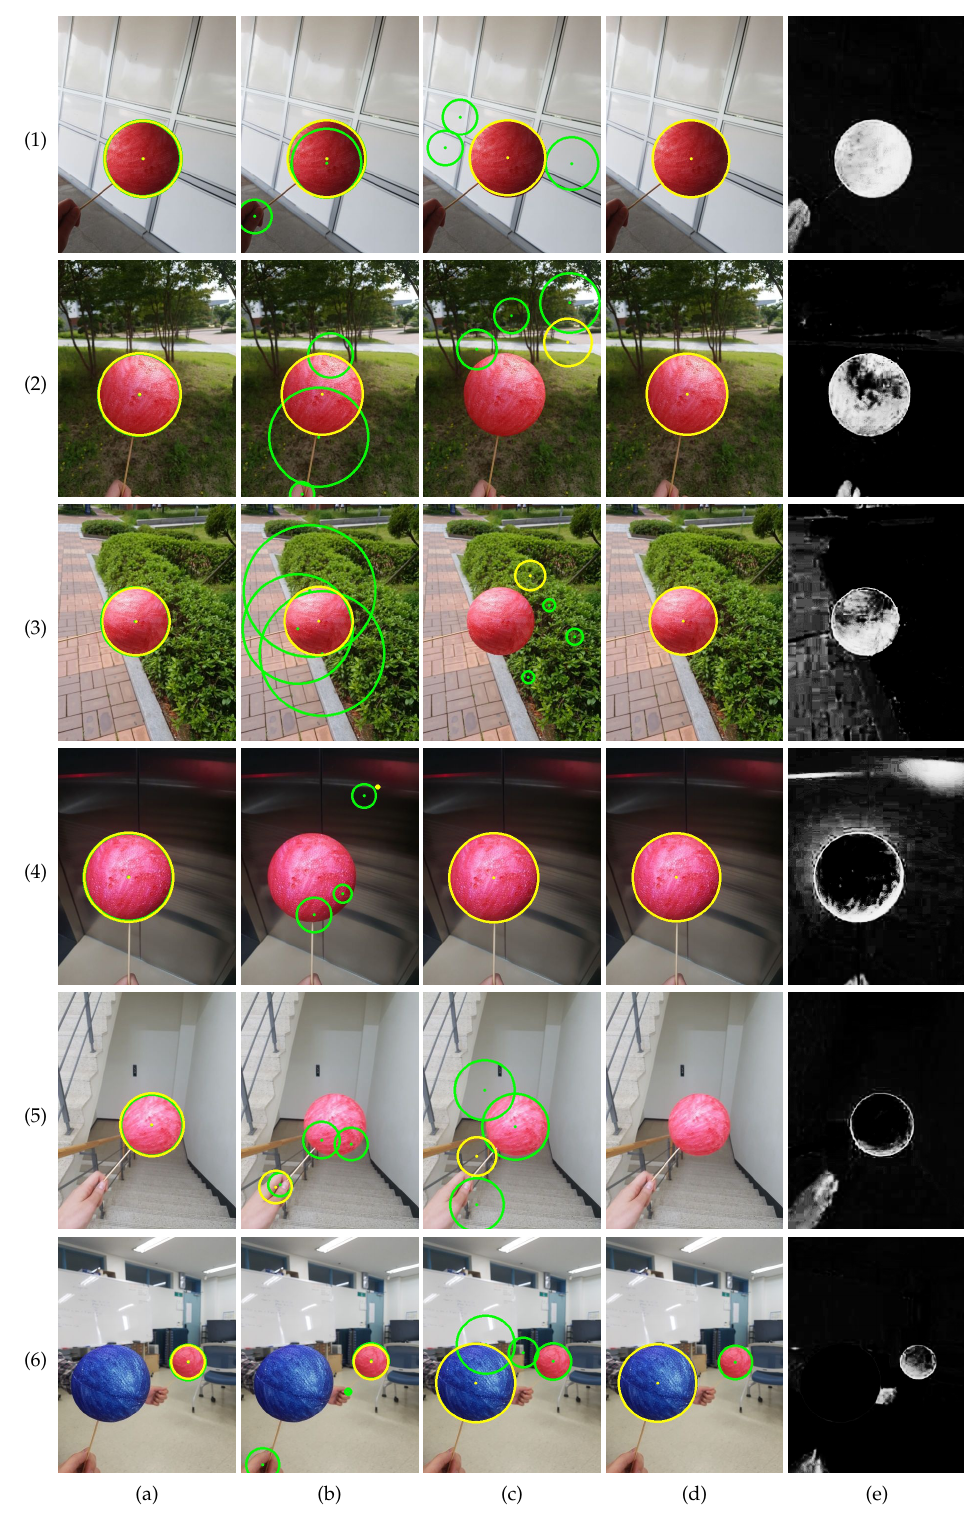
Figure 7. Top four circles detected by the methods (styrofoam ball set). ( a ) Proposed method. ( b ) Kwon et al. [21]. ( c ) CHT [36]. ( d ) EDCircles [44]. ( e ) Color probability images [21]. From ( a – d ), the best circles are drawn in yellow, while the remaining circles are drawn in green. Some circles have similar centers and radii in ( a , b ), so the numbers of circles in the images may seem less than four. Best viewed in